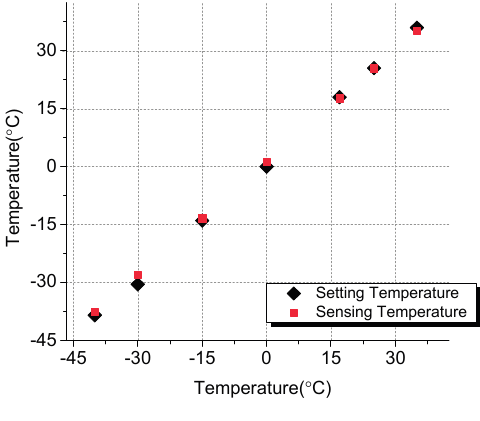
Figure 4. Temperature measured by the fabricated thermocouple.